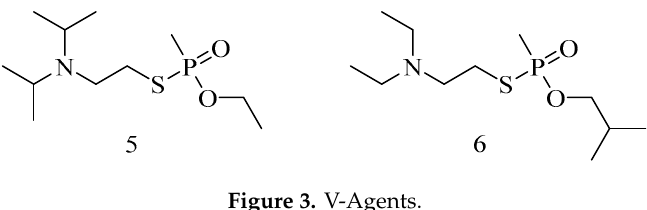
Figure 3. V-Agents.